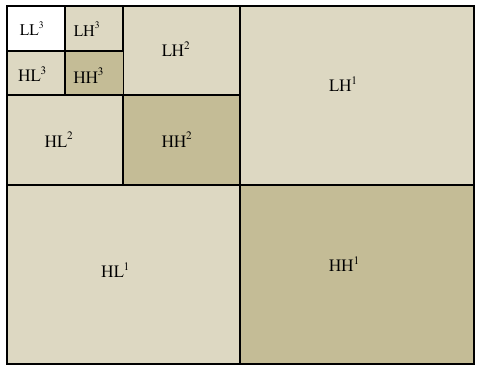
Fig. 1: Structure of 3 level wavelet